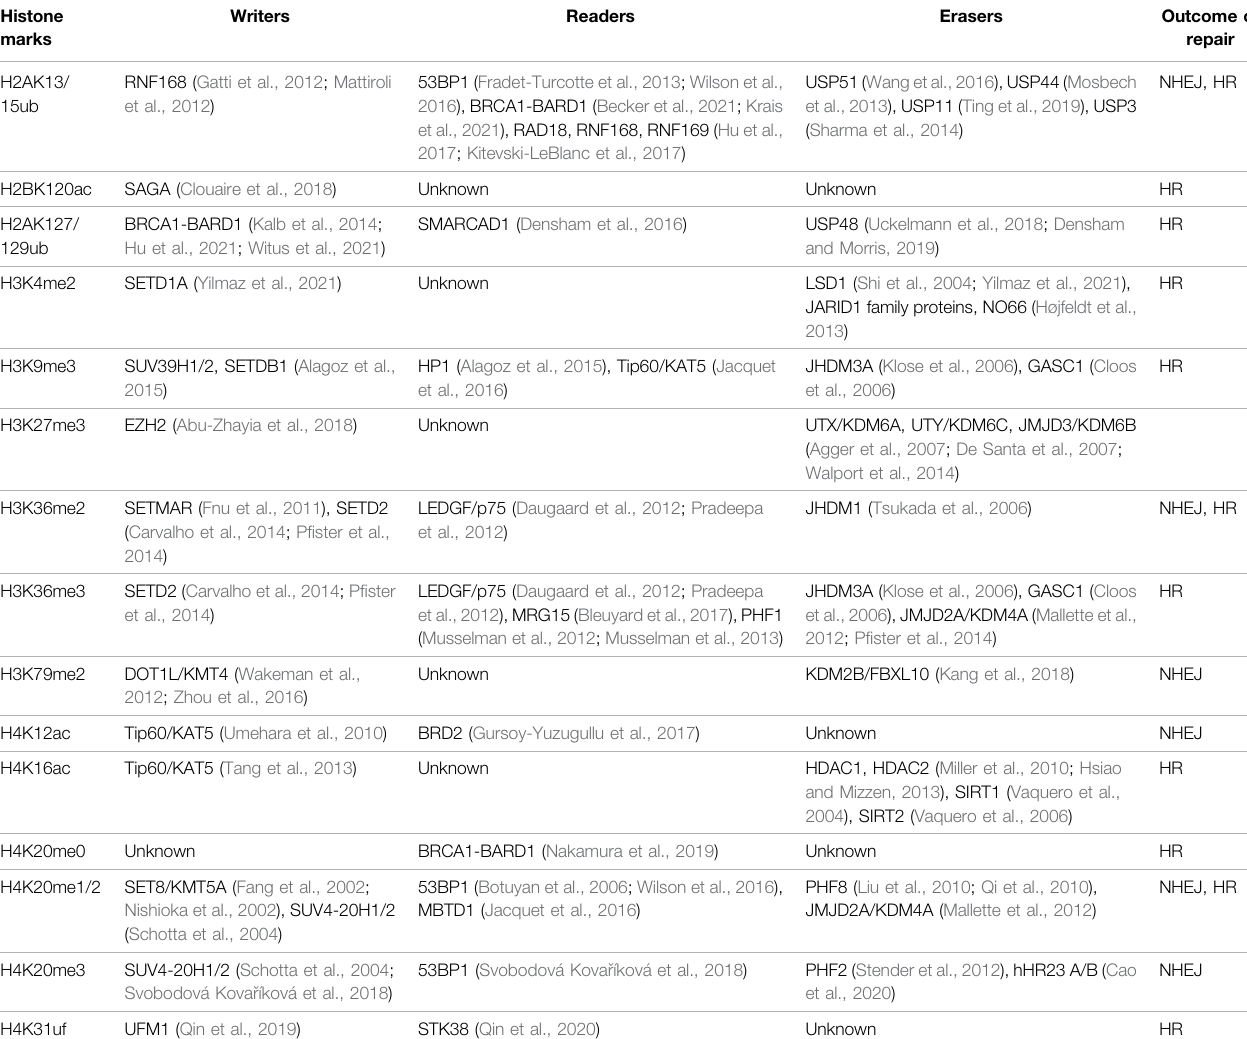
TABLE 1 | Histone Marks that are involved in DSB repair choice in mammalian